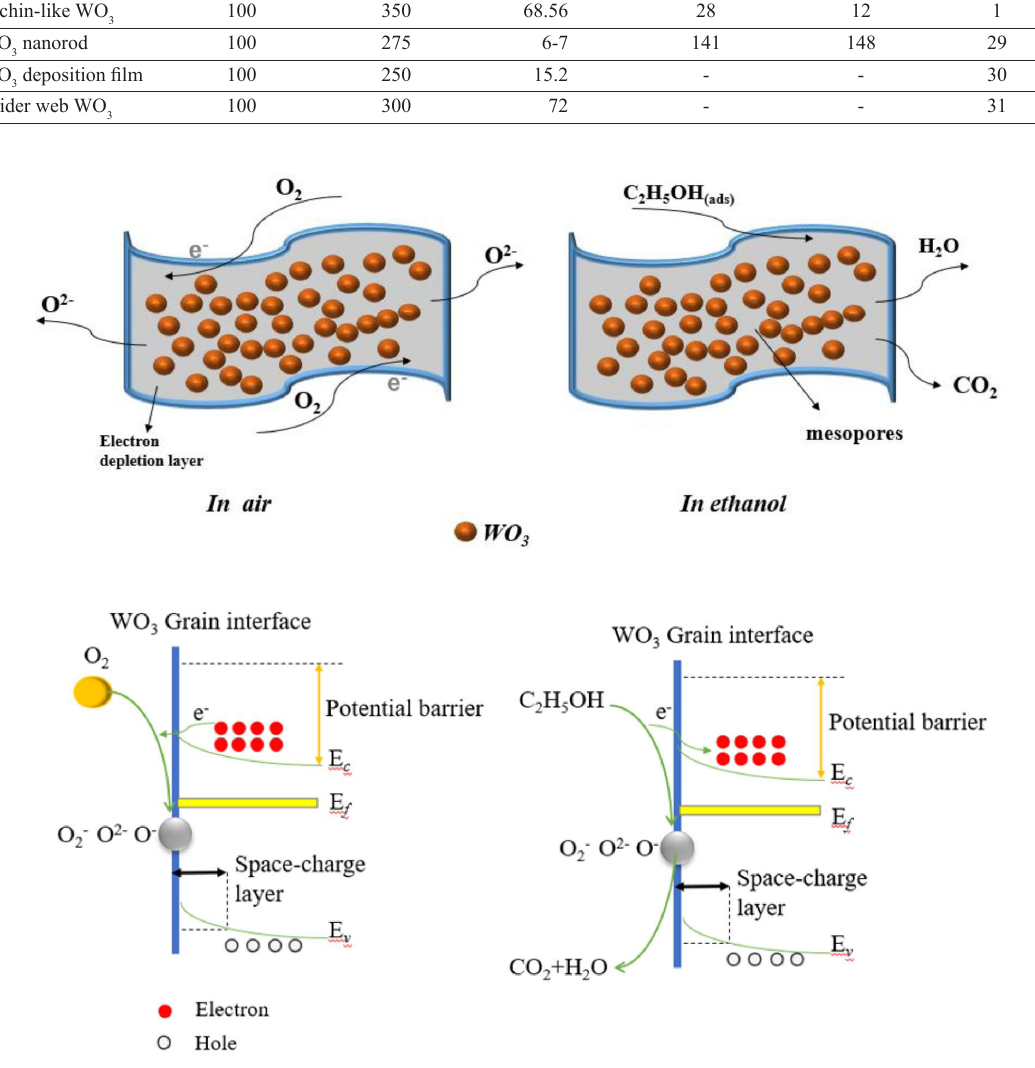
sensor sensing mechanism. 3